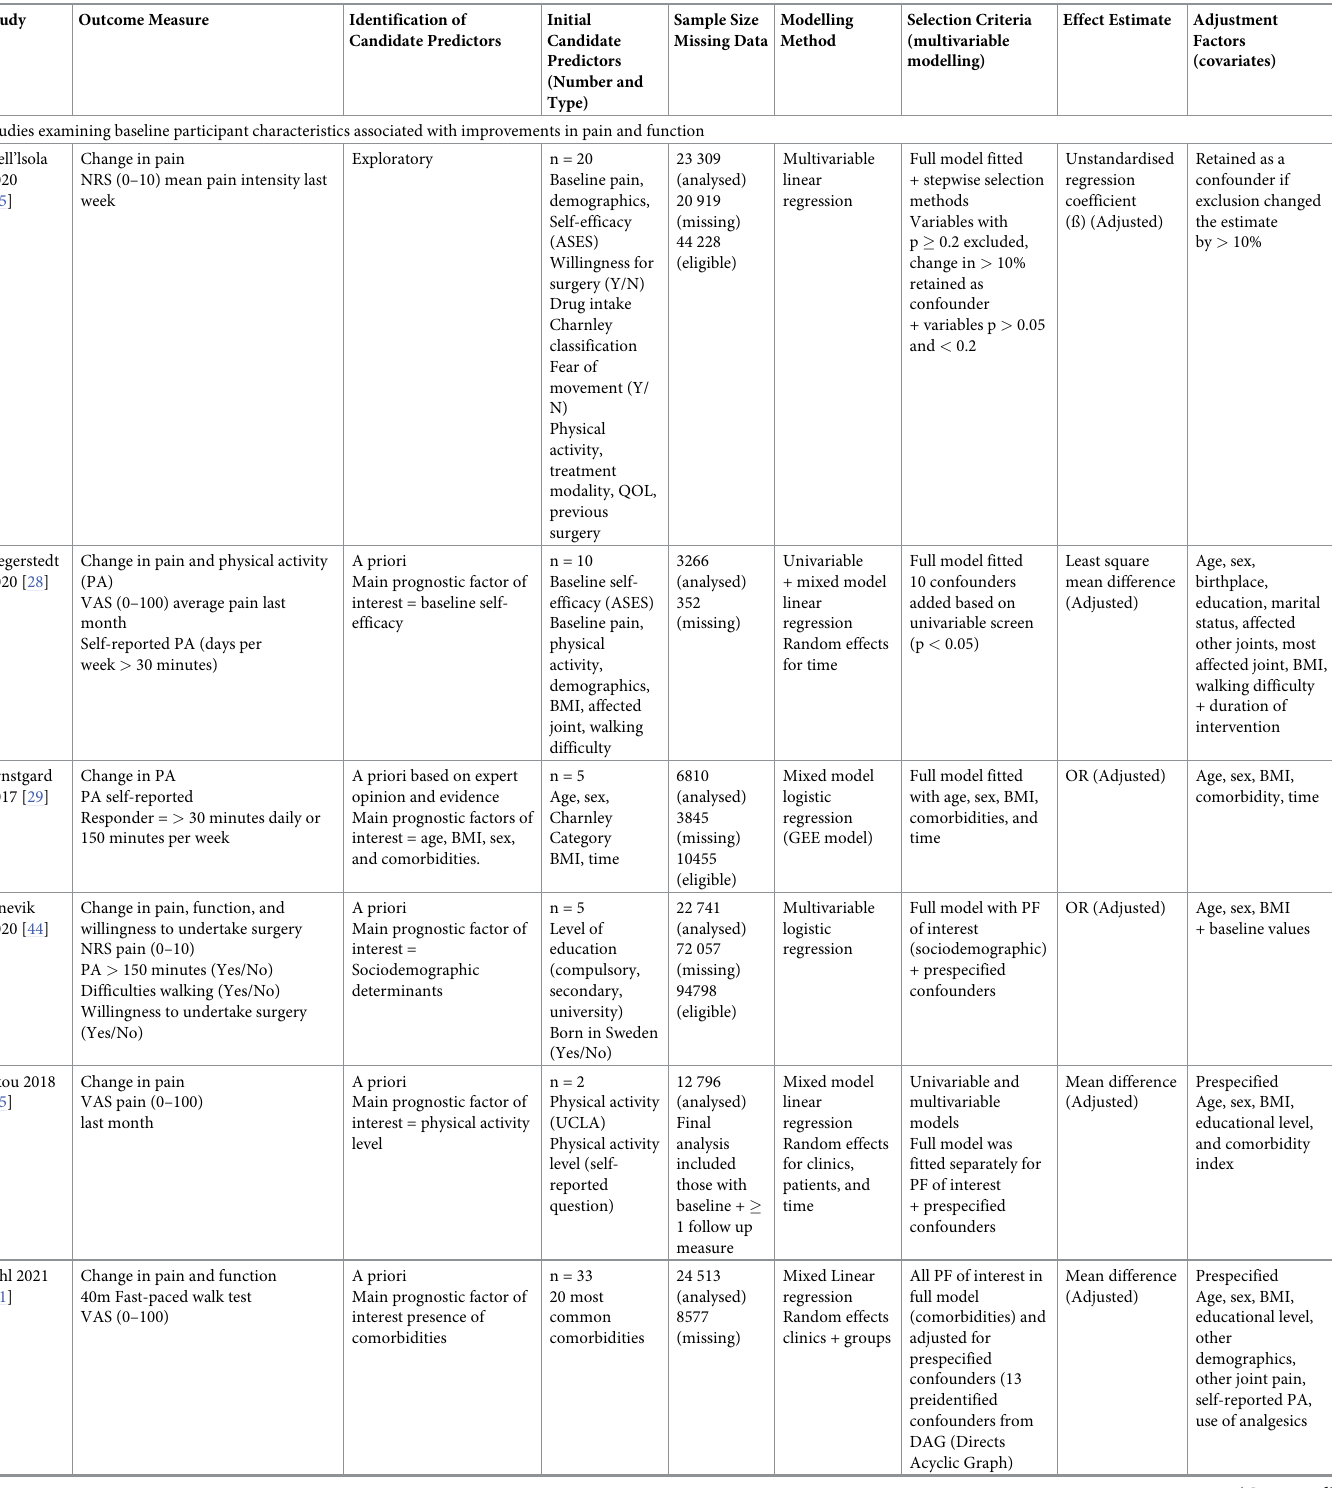
Table 2. Study outcomes and statistical methods (including prognostic factors, sample size, modelling method and sets of adjustment